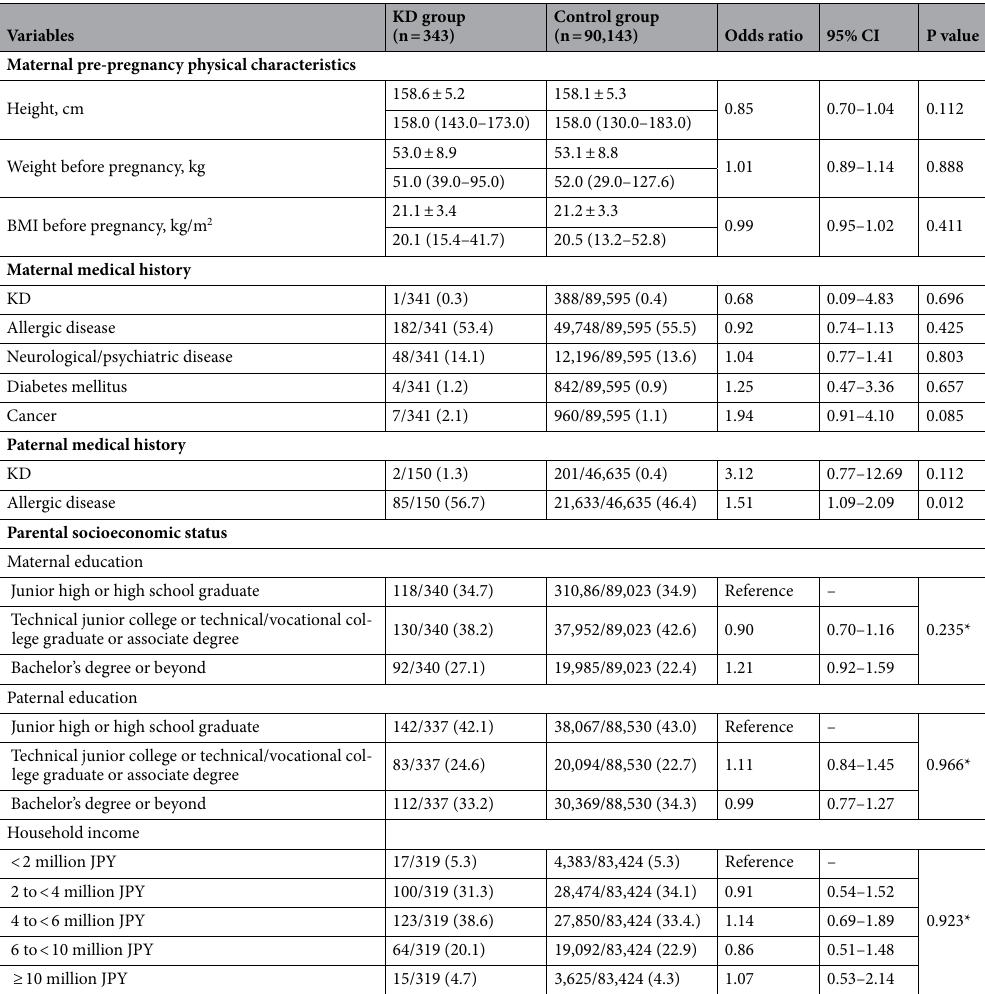
Table 1. Parental characteristics of the study population. Data are presented as n (%), mean ± standard deviation, or median (range). BMI body mass index, KD Kawasaki disease, JPY Japanese yen, 95% CI 95% confidence interval. *P-value for